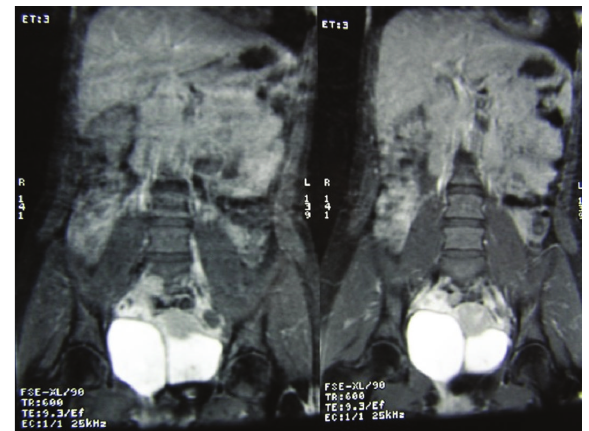
Figure 2: Magnetic resonance urography showing two bladders without